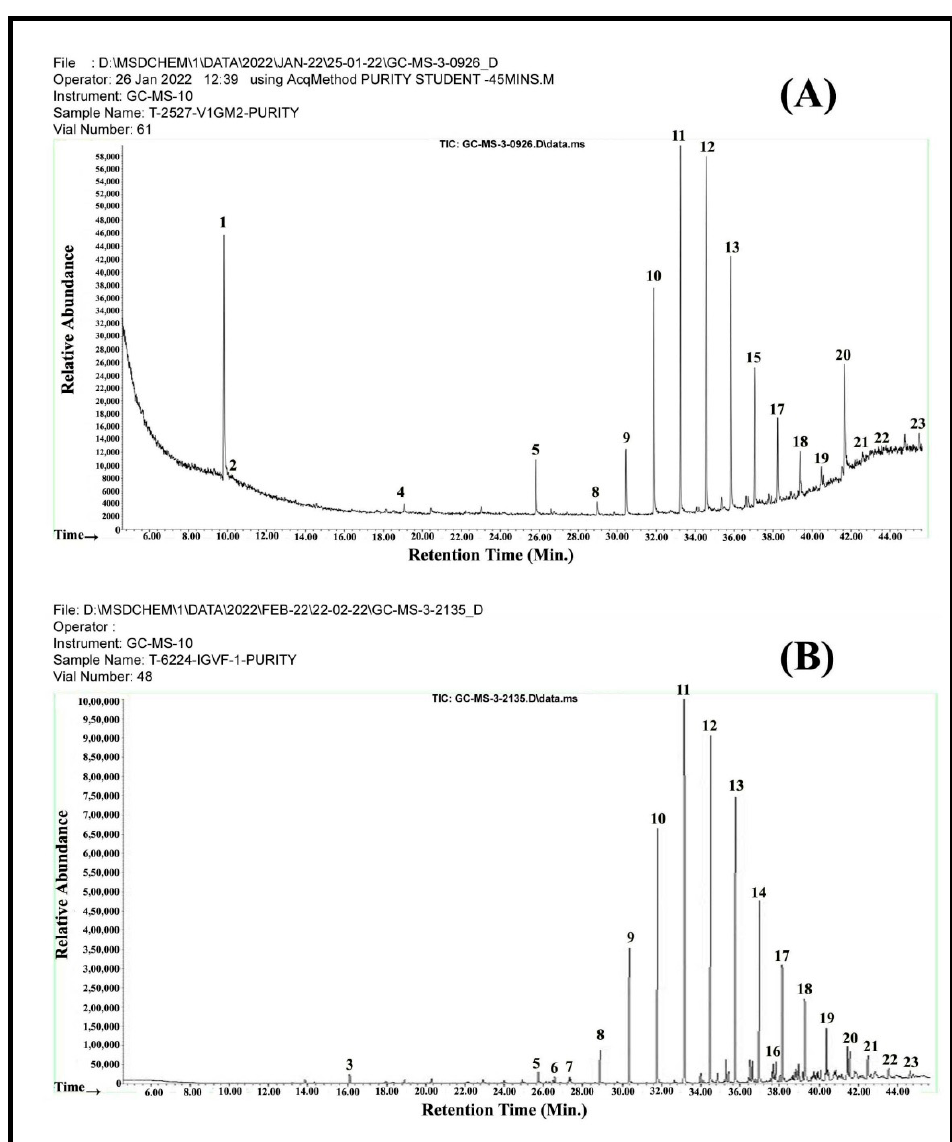
Figure 13. The gas chromatographic profiles of the volatile compounds of male ( A ) and female ( B ) interdigital gland secretion. For details, please refer Table 1.